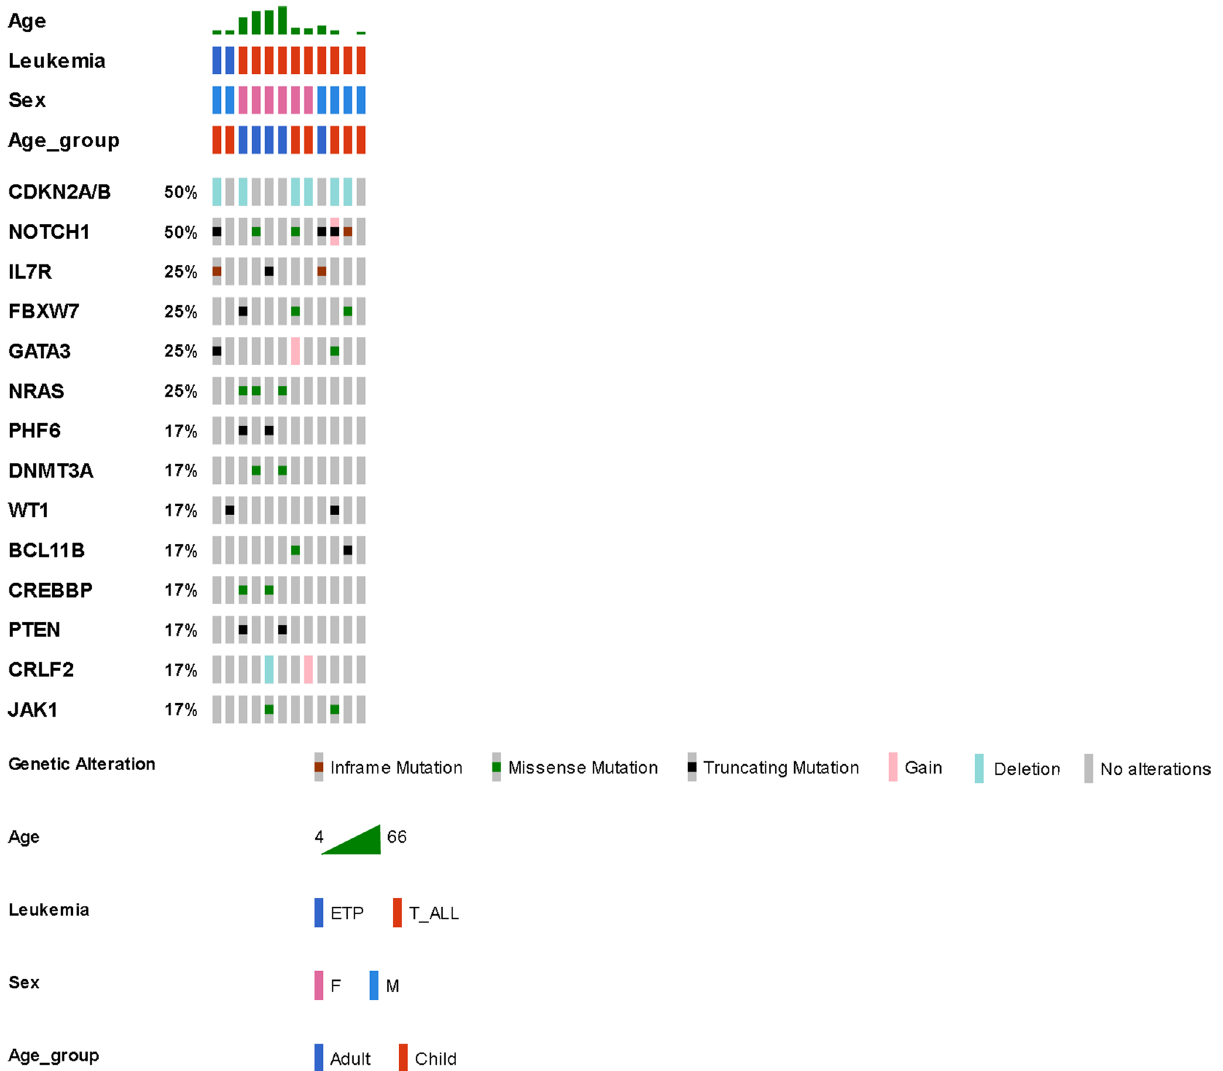
Figure 1. Most common genetic alterations in T-cell lymphoblastic leukemia/lymphoma (T-ALL) and ETP (Early T-cell Precursor Acute Leukemia). Only ≥ two patients with gene-alterations are shown in the figure. Data were analyzed by OncoPrinter (cBioPortal Version 1.14.0, Gao et al., Sci. Signal. 2013 and Cerami et al., Cancer Discov. 2012). Truncating mutations (nonsense, frameshift deletion, frameshift insertion, splice site); inframe (inframe deletion, inframe